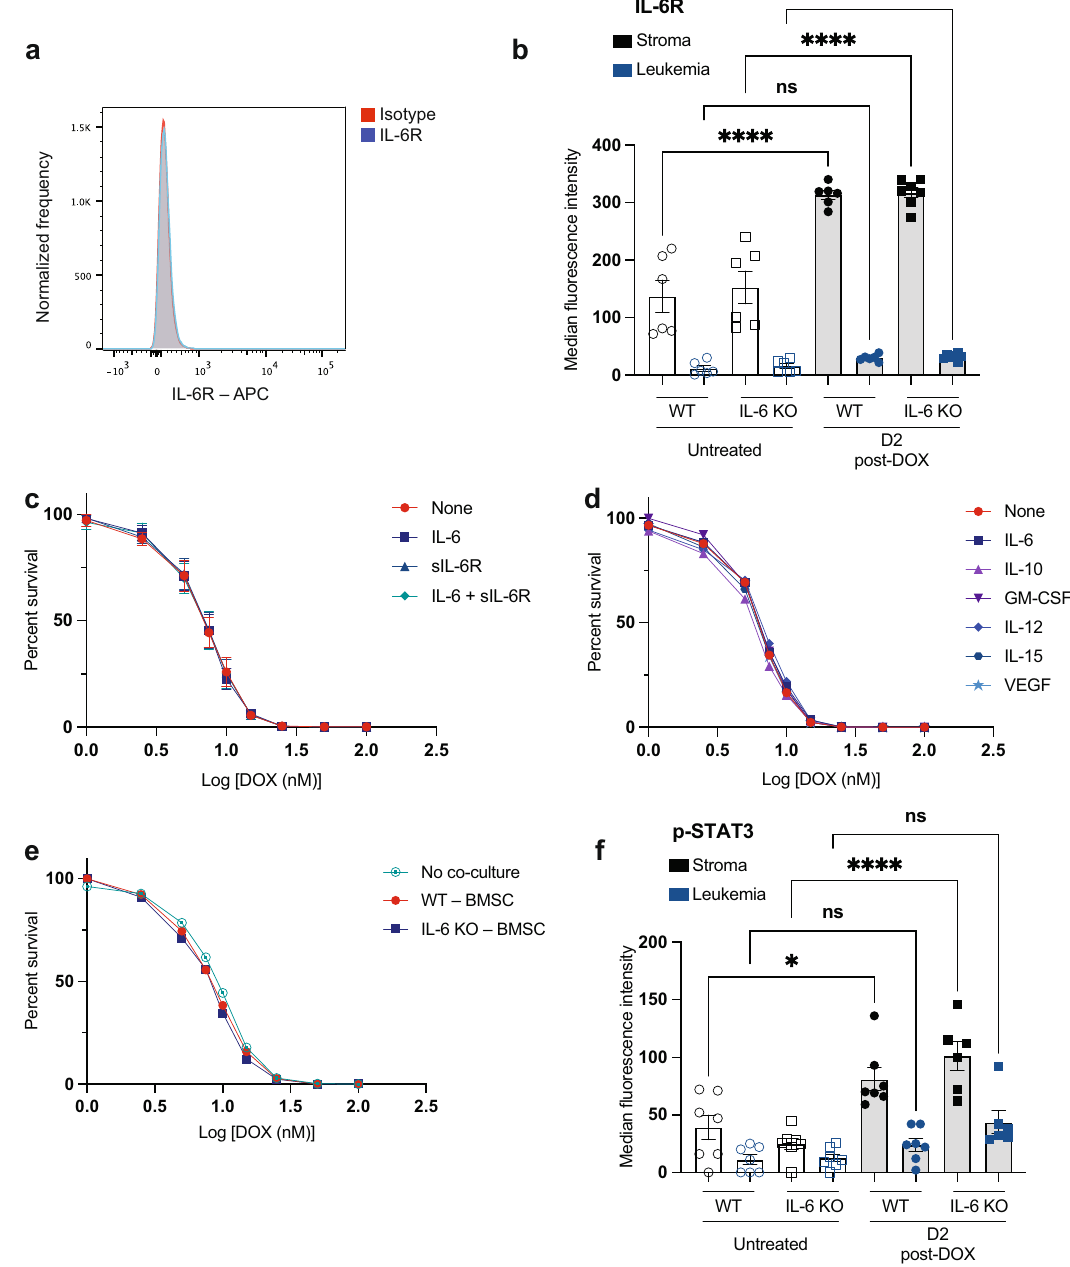
Fig. 2 IL-6 does not promote intrinsic B-ALL chemoresistance. a A fl ow cytometry plot showing IL-6R expression on the surface of leukemic cells in vitro. Histograms for IL-6R and isotype control-stained cells are overlaid. b A graph showing IL-6R expression in the bone marrow of leukemia-bearing mice pre- and post-doxorubicin (DOX) treatment. Data were quanti fi ed by fl ow cytometry. mCherry + leukemia cells were used to distinguish stromal and leukemia cells. Median APC intensity from IL-6R stained cells minus isotype control-stained cells was calculated. Data from 2 independent experiments are shown, and represented as mean ± SEM. n = 6 per cohort, except n = 7 for both IL-6 KO-D2 post-doxorubicin stroma and IL-6 KO-D2 post-doxorubicin